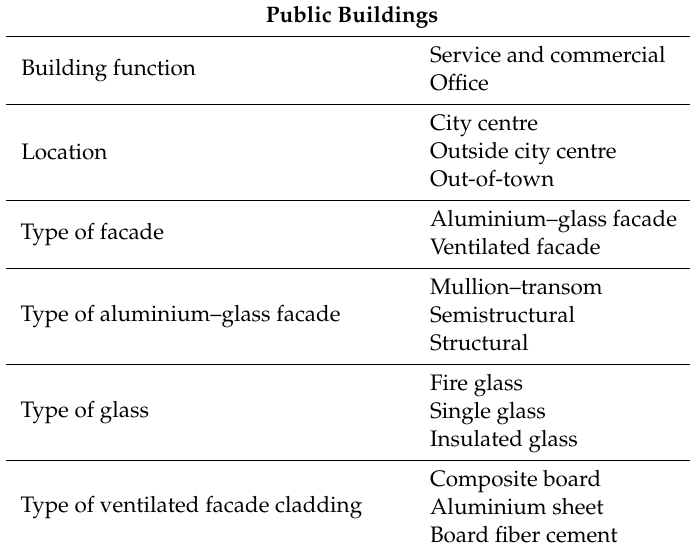
Table 1. Characteristics of the analysed buildings.